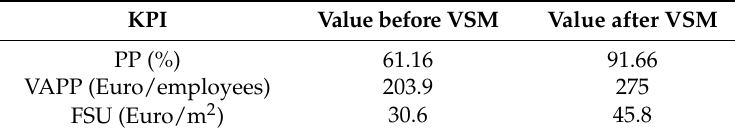
Table 5. Key performance indicators (KPI) for simulated